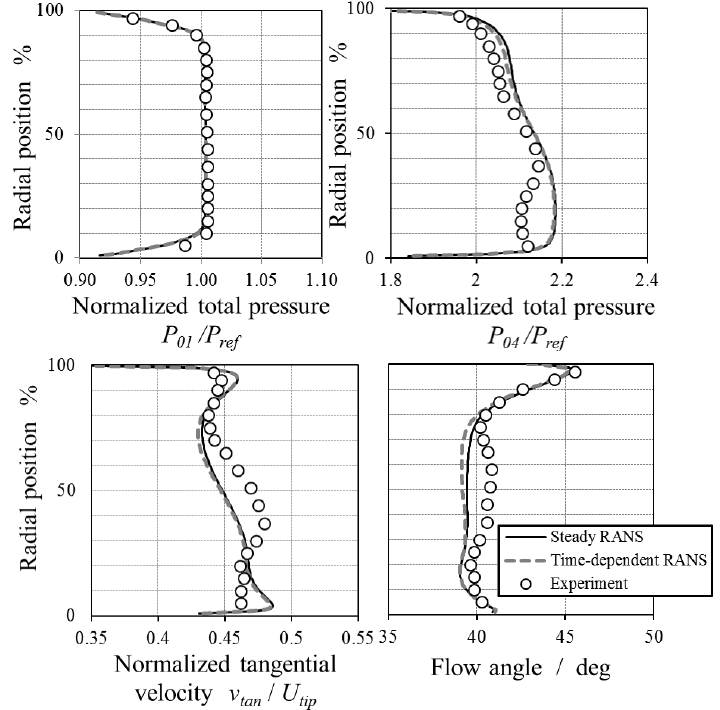
Figure 3. Circumferentially mass-averaged radial profiles at Station 1 and Station 4 showing the comparison between computational fluid dynamics (CFD) and experimental data. Experimental data from [18,29].